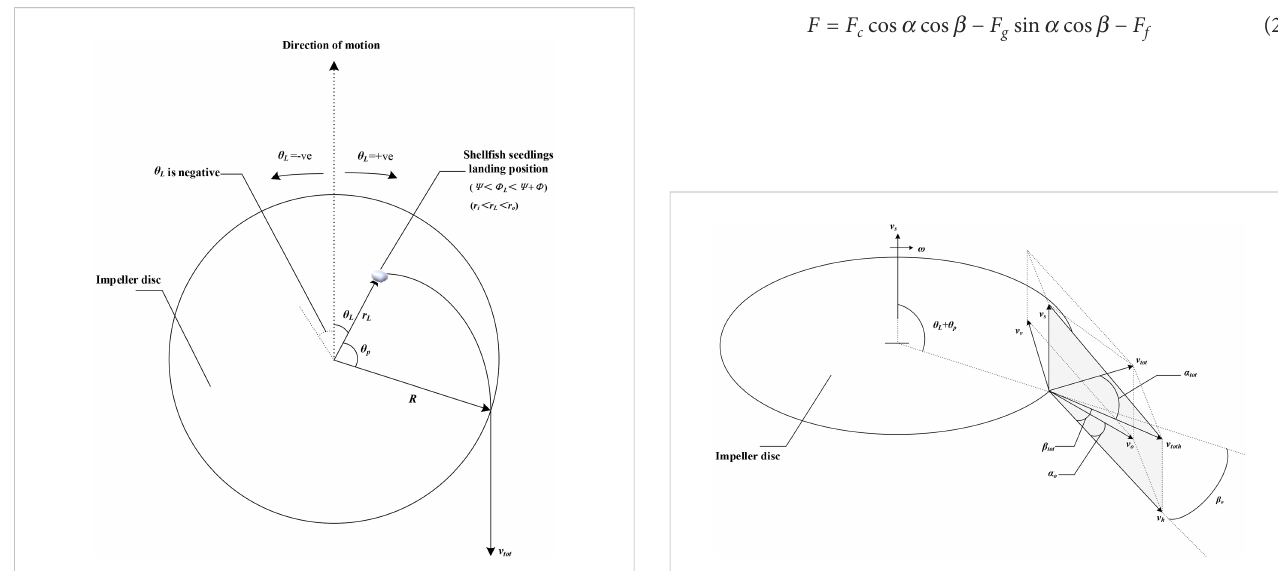
FIGURE 5 Top view of the trajectory of shells on the impeller disk.